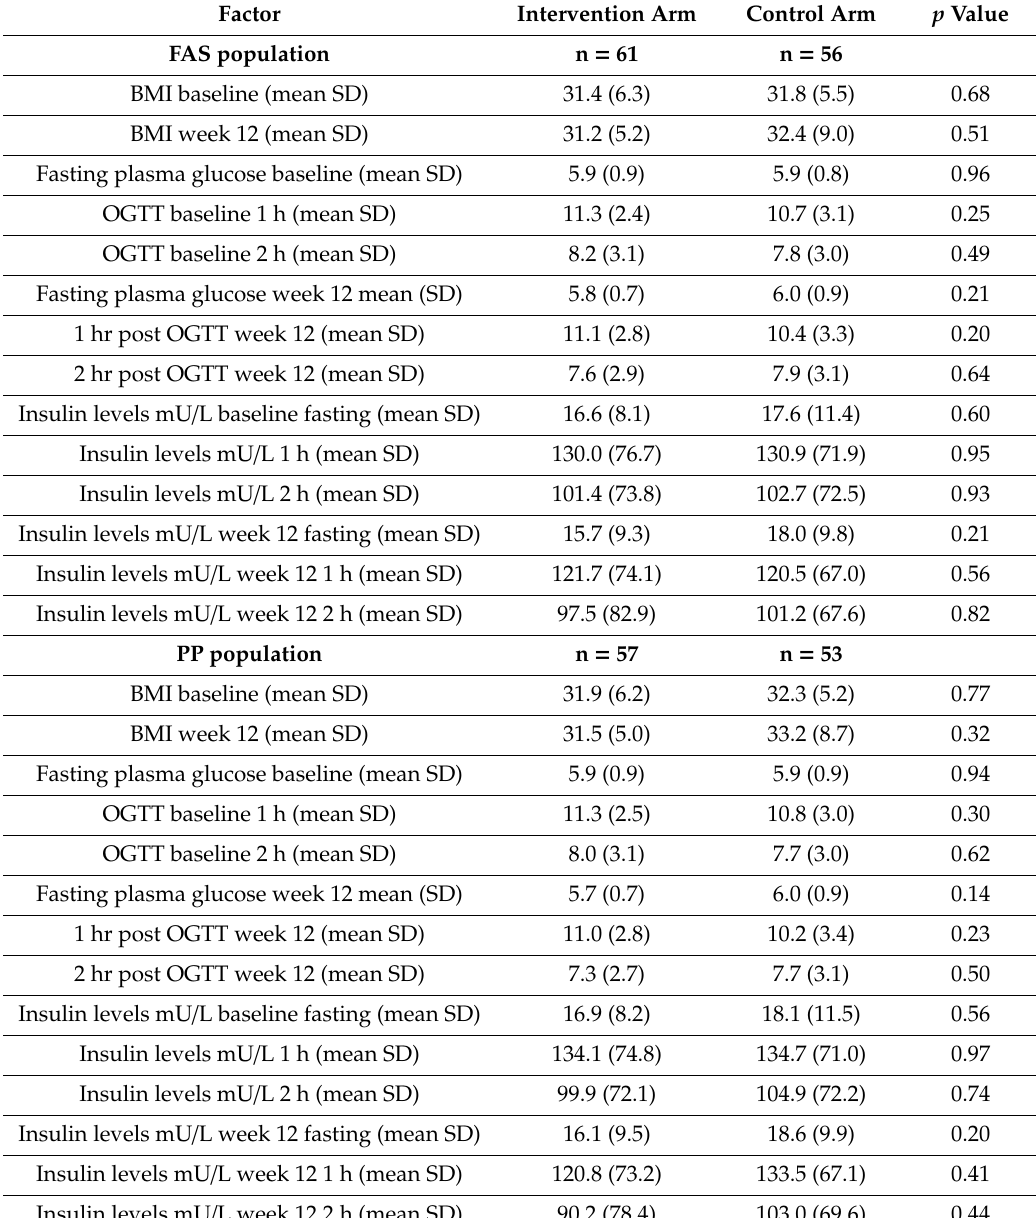
Table 6. Additional physiological